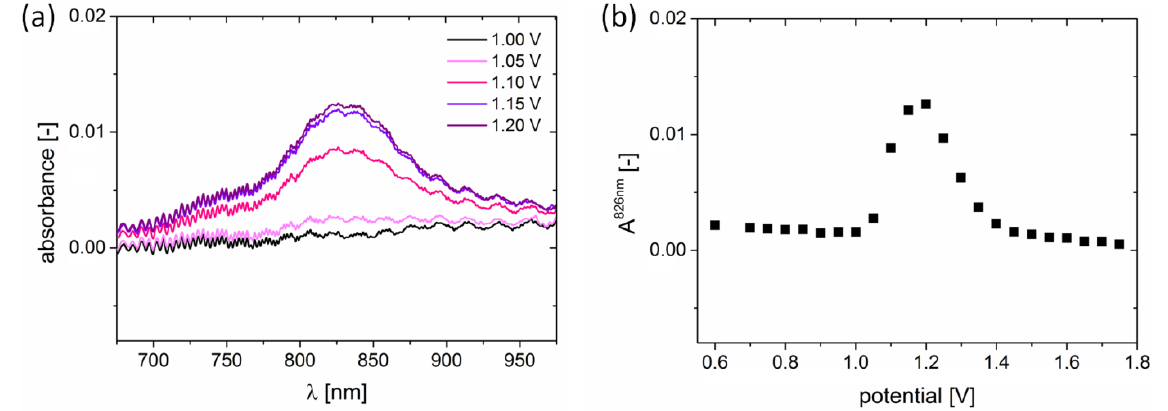
Figure 6. ( a ) UV-Vis spectra evidencing the electrochemical formation of the H5T radical cation. The sample consisted of 1 × 10 − 3 mol dm − 3 H5T solution in dichloromethane with 0.2 mol dm − 3 of Bu 4 NBF 4 as the supporting electrolyte. ( b ) Evolution of A 825nm absorption maxima as a function of applied potential.